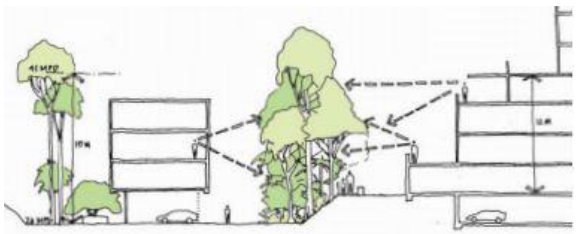
Figure 2. Landscape and outlook evaluation of dwell- ings. Source: Department of Sustainability and Envi- ronment (2004).